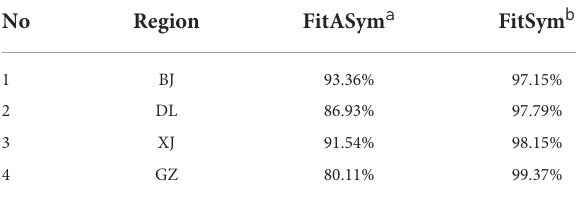
TABLE 4 Analysis of the “Goodness of Fit” in symptomatic and asymptomatic infections.